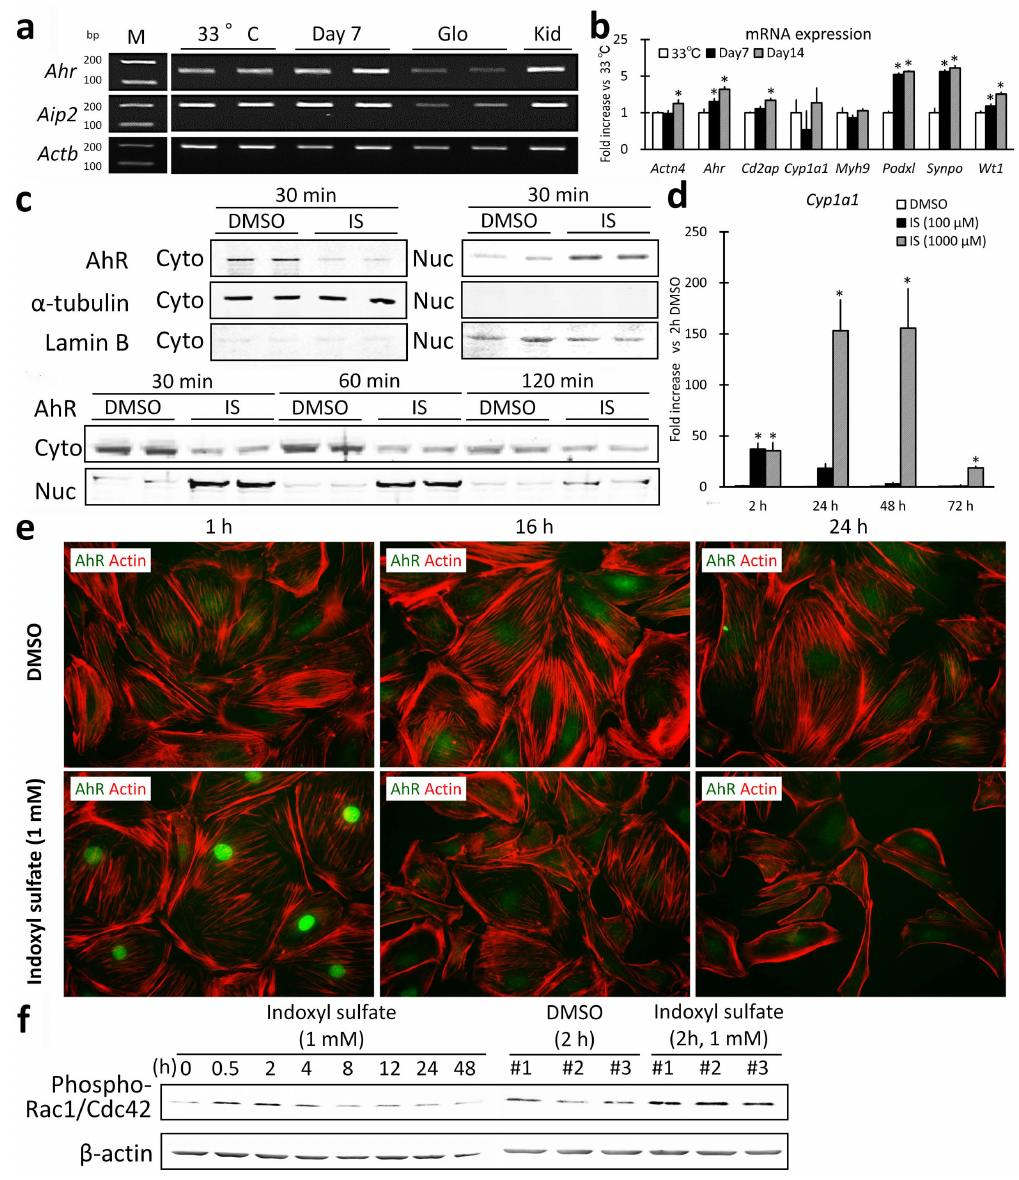
Figure 5. Indoxyl sulfate activated the aryl-hydrocarbon receptor and altered morphology in mouse podocytes. RT-PCR analysis for the following genes is shown: Ahr , Aip , and Actb , referring to aryl hydrocarbon receptor, aryl hydrocarbon receptor-interacting protein, and beta actin, respectively ( a ). M refers to the size marker. 33 u C refers to mouse podocytes cultured at 33 u C. Day 7 refers to mouse podocytes cultured at 37 u C for 7 days. Glo and Kid denote the glomerulus and kidney isolated from an FVB/N mouse. Podocyte marker mRNA expression was measured in mouse podocytes; note that Ahr mRNA expression increased with podocyte differentiation ( b ). 33 u C refers to mouse podocytes cultured at 33 u C. Day 7 refers to mouse podocytes cultured at 37 u C for 7 days. Day 14 refers to mouse podocytes cultured at 37 u C for 14 days. Data generated using real-time PCR; n=3, mean 6 S.D. Fold increase vs. 33 u C. * denotes significant differences vs. 33 u C ( P , 0.05). Immunoblotting for AhR in differentiated mouse podocytes demonstrates nuclear translocation following indoxyl sulfate exposure ( c ). Cyto denotes cytoplasmic protein, Nuc denotes nuclear protein extracted from dimethyl sulfoxide (DMSO)-treated or indoxyl sulfate (IS)-treated mouse podocytes. a -Tubulin and Lamin B were examined to test for protein contamination with cytoplasmic or nuclear proteins, respectively. Each lane contained 20 m g of protein. In a dose-response and time-course study, Cyp1a1 mRNA expression in indoxyl sulfate (IS)-exposed mouse podocytes was measured by real-time PCR ( d ). n=3, mean 6 S.D. Fold increase vs. each DMSO control. * denotes significant differences vs. DMSO in each time group ( P , 0.05).Immunofluorescence images of differentiated mouse podocytes exposed to DMSO or indoxyl sulfate for 1 h, 16 h, and 48 h, with staining for AhR (green) and actin (red, phalloidin staining) ( e ). Indoxyl sulfate exposure is associated with a brief, reversible migration of AhR into the nucleus. Immunoblotting for phosphorylated Rac1/Cdc42 GTPases demonstrated an increase in protein following exposure to indoxyl sulfate for 2 h ( f ). Each lane contained 5 m g of protein and triplicate wells are shown at 2 h.